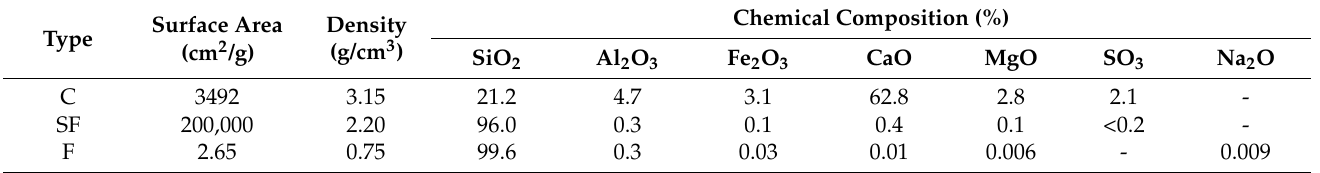
Table 5. Physical and chemical properties of materials.